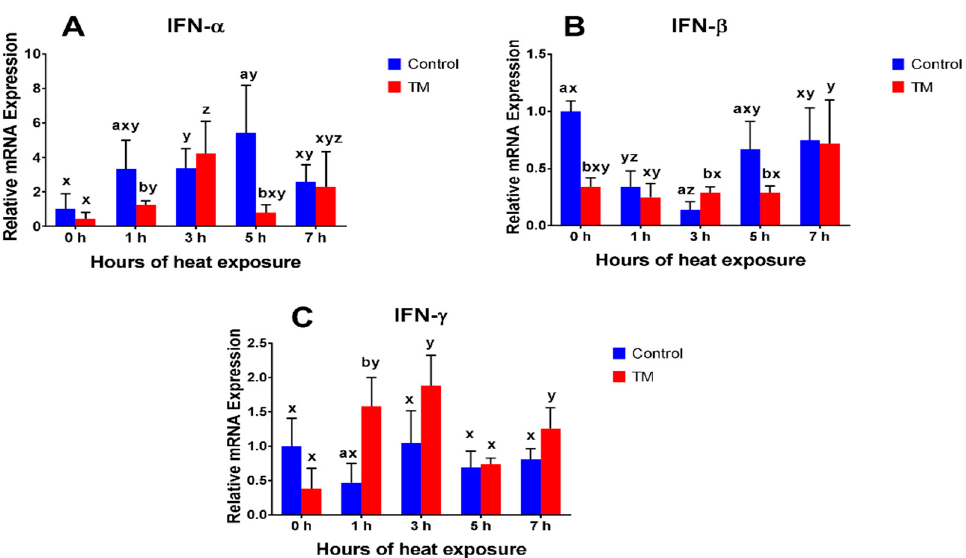
Figure 2. Impact of AHSF at 40 °C for 1, 3, 5, and 7 h on post-hatch day 28 on splenic mRNA levels of ( A ) IFN- α , ( B ) IFN- β , and ( C ) IFN- γ in broiler chickens subjected to TM ( n = 5). The values in the chart indicate folds changes of mRNA levels compared to the control groups at 0 h before AHS. a,b Within the same point of time, values ± SD of TM and control groups with different superscripts are significantly different ( P 0.05). x–y Within the same treatment group and between different points of time, values ± SD with different